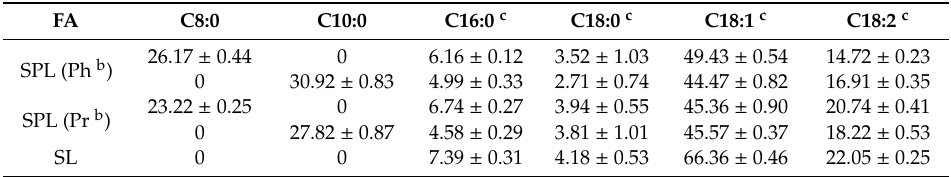
Table 1. Total FA composition (mol%) of SLs and SPL products a